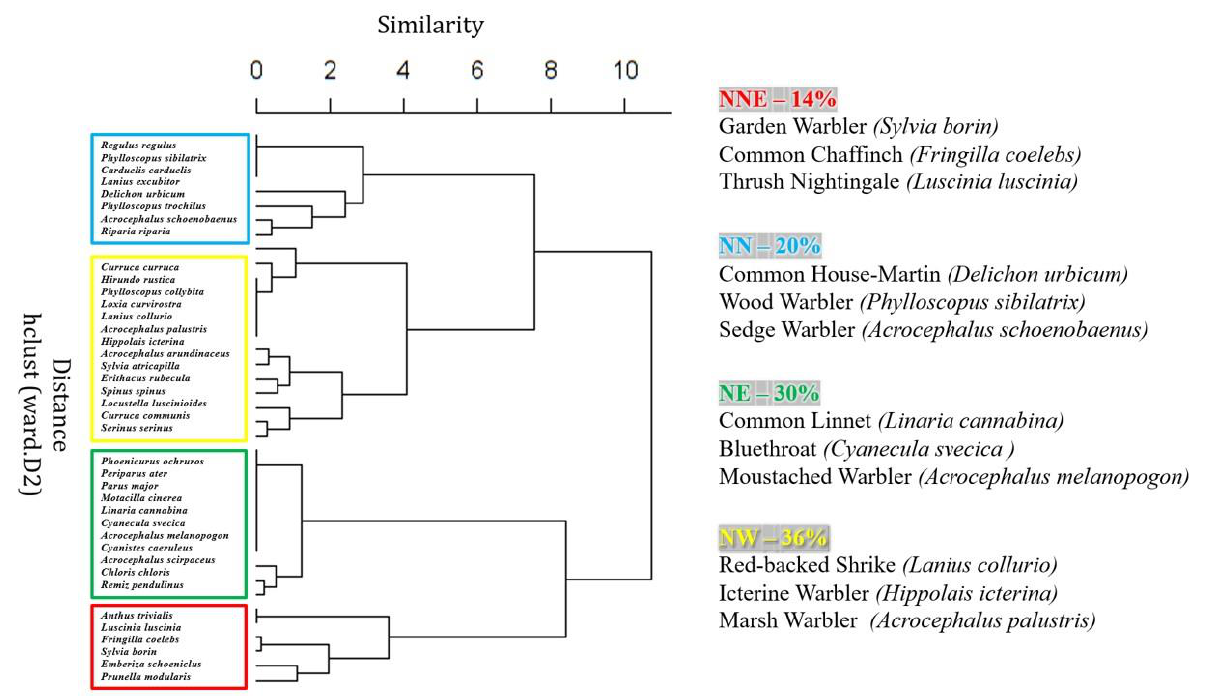
Figure 2. Species guilds according to four geographical clusters, directions from where the species arrive according to the position of Slovenia. For particular guilds, the percentages of recoveries of each geographical cluster are given, including corresponding species with higher percentages of presence. Table 3. Population trends in species trait guilds. Abbreviations: SE: standard error. Significant